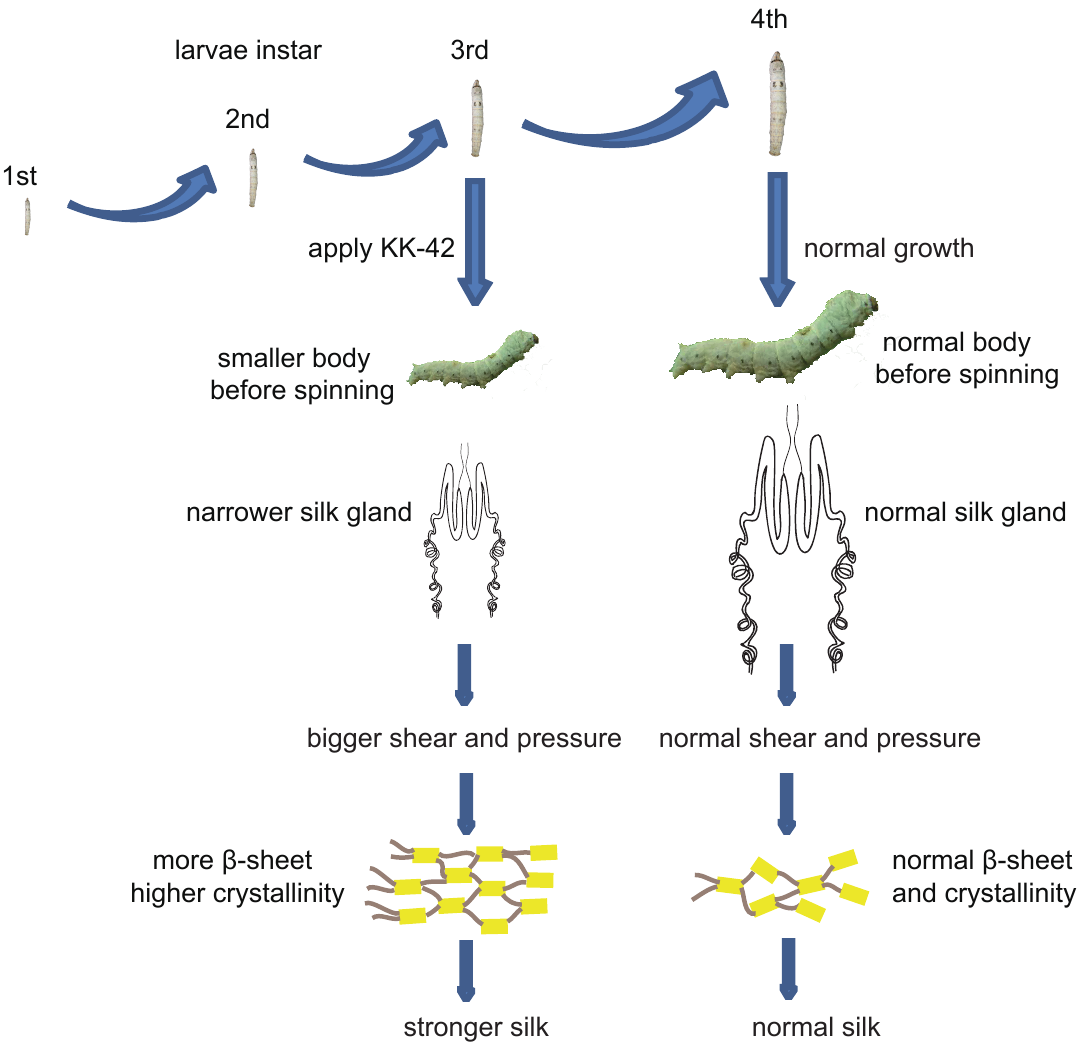
Figure 10. Model of the improvement in the mechanical properties of silk induced by anti-juvenile hormone